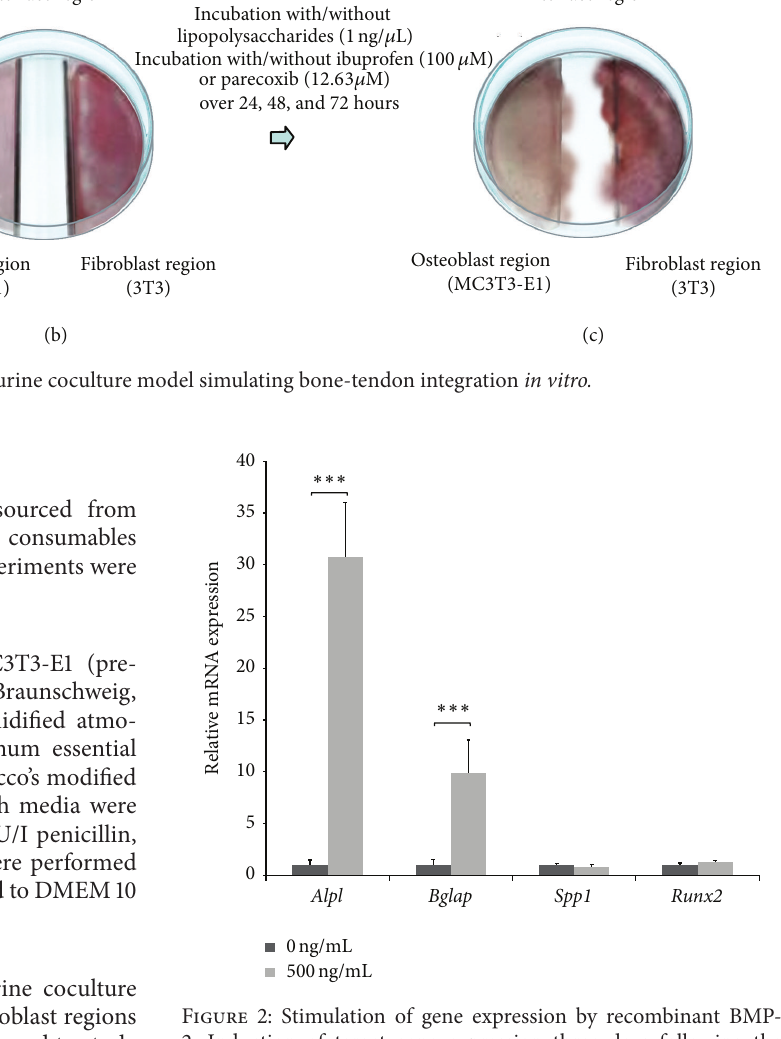
Figure 2: Stimulation of gene expression by recombinant BMP- 2 . Induction of target gene expression three days following the application of recombinant BMP-2 (500ng) at the osteoblast region served as positive control. Gene expression was measured 3 days after the stimulation with BMP-2 (500ng/mL) and normalized to housekeeping genes. Alpl : alkaline phosphatase; Bglap : bone gamma-carboxyglutamate protein; BMP-2: bone morphogenetic protein-2; Runx2 : runt-related transcription factor 2. 𝑃 values are provided as follows: ∗ 𝑃 < 0.05 , ∗∗ 𝑃 < 0.01 , and ∗∗∗ 𝑃 < 0.001 . from the plate using a cell scraper and collected in three separate tubes (osteoblast, interface, and fibroblast regions). sulfoxide (DMSO, 520 𝜇 M) and NaCl (36.02 𝜇 M)